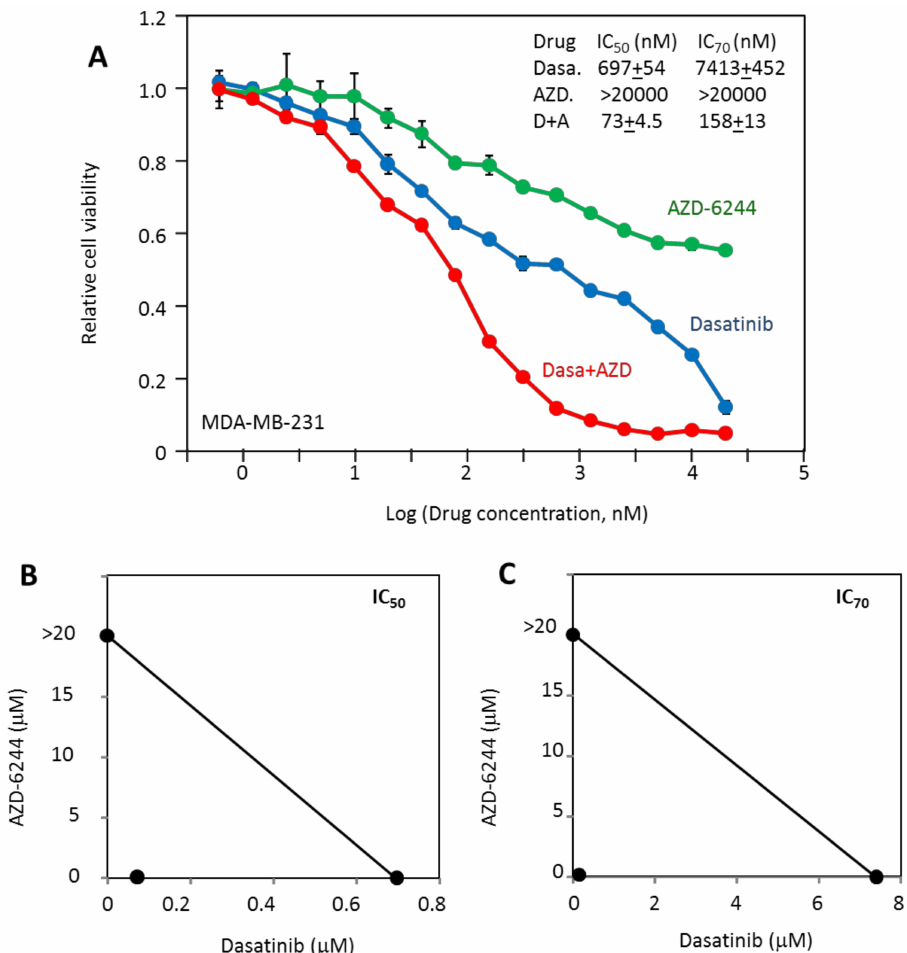
Figure 2. Inhibition of MDA-MB-231 cell viability by dasatinib, AZD-6244, and their combination. ( A ) The responses of MDA-MB-231 cells to dasatinib and AZD-6244 are compared to their response to the combination of both at equal molar concentrations; ( B ) isobolograms of AZD-6244 and dasatinib combination analysis at 50% inhibition; ( C ) isobolograms of AZD-6244 and dasatinib combination analysis at 70% inhibition. The results are representative of two independent experiments of